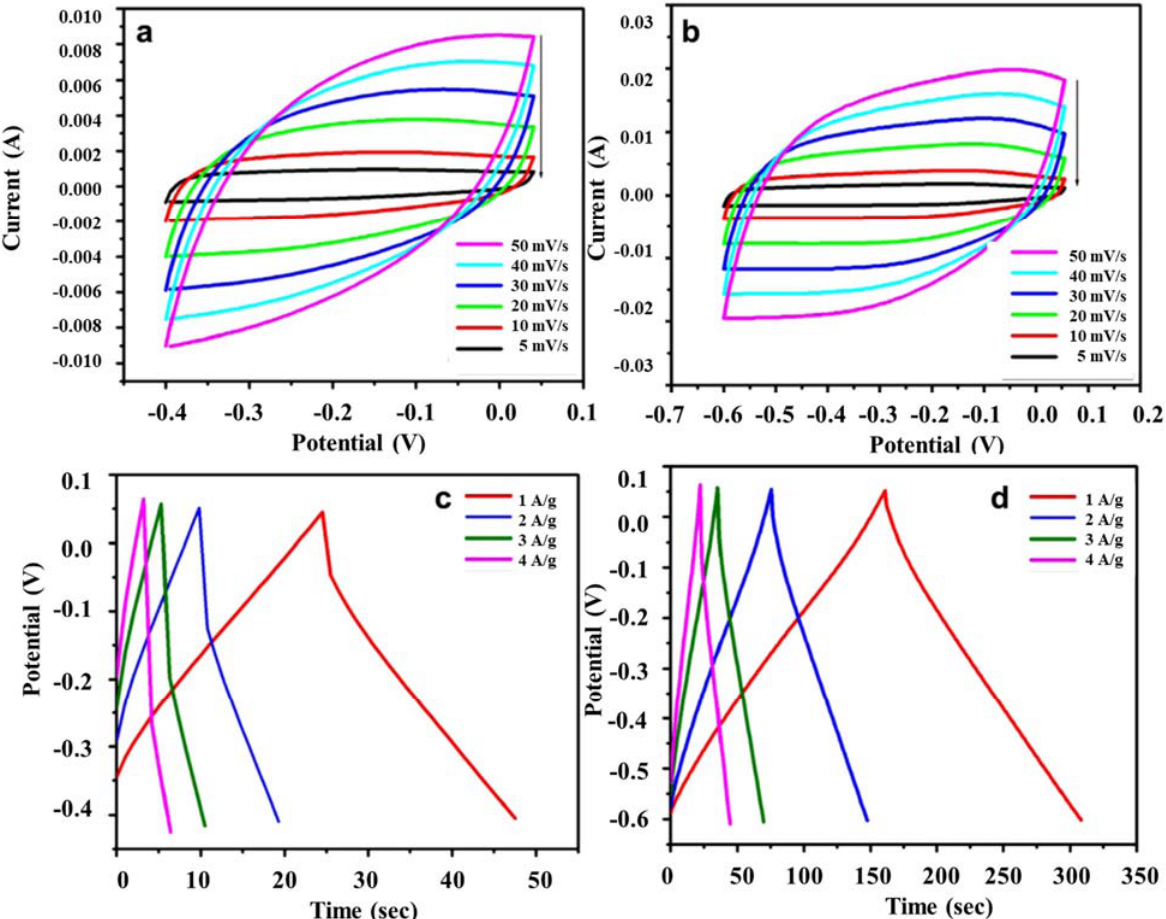
Figure 9. CV curves of ( a ) thermally reduced graphene, and ( b ) B-GNS electrode measured at different scan rates, galvanostatic charge–discharge curves of ( c ) thermally reduced graphene, and ( d ) B-GNS electrode at various current densities. Adapted from Thirumal et al. [104], with permission from Elsevier. Copyright (2016).